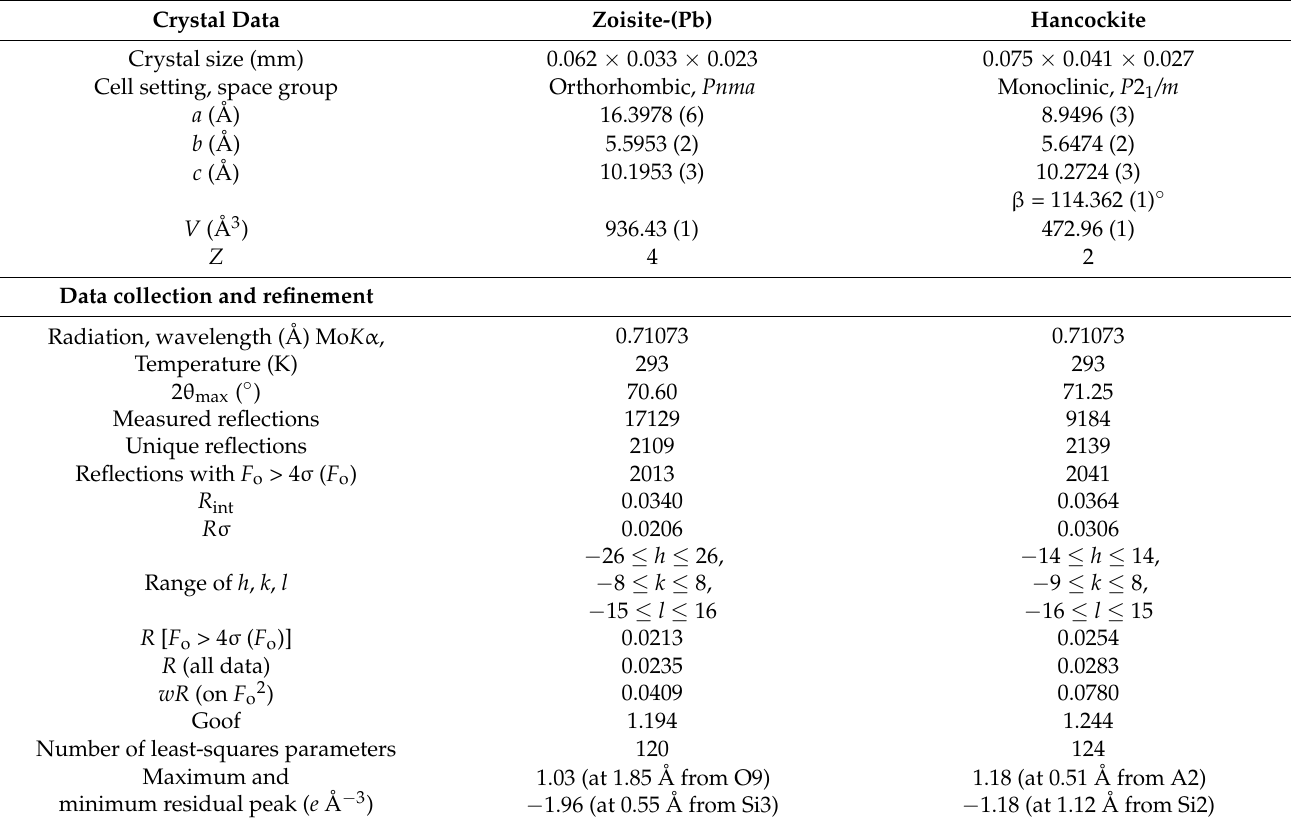
Table 5. Crystal and experimental data for zoisite-(Pb) and